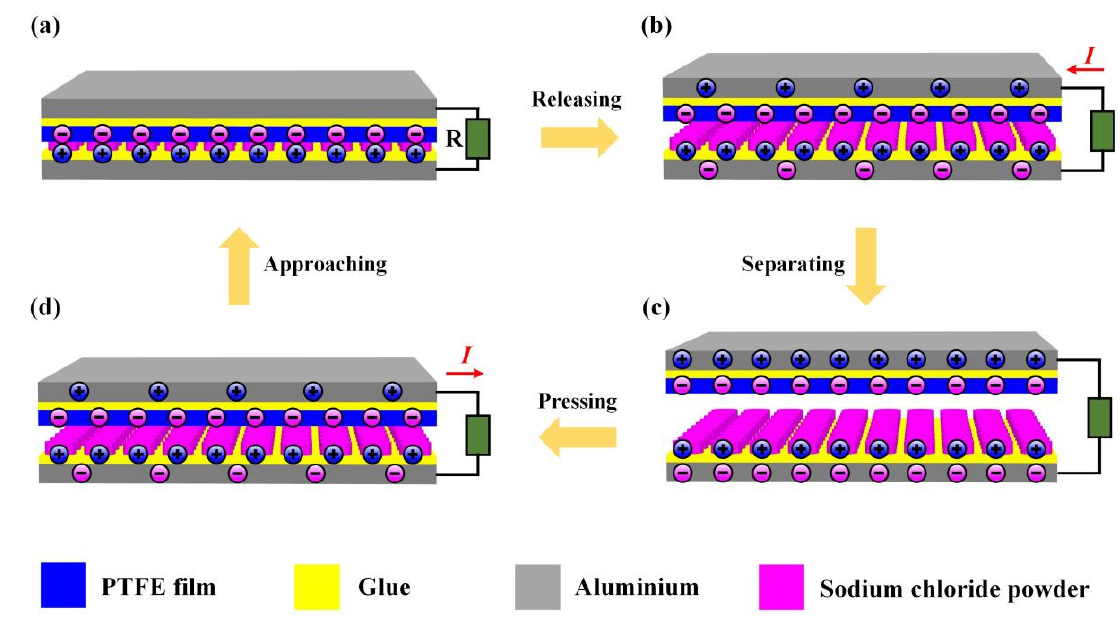
Figure 2. ( a – d )The operating principle of S-TENG.